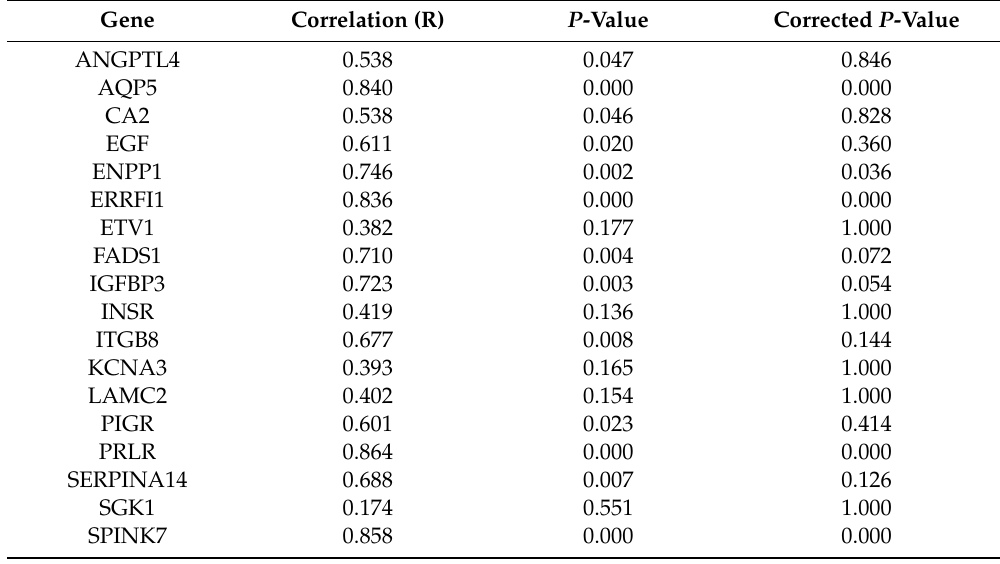
Table 2. Pearson’s correlation of RNA sequencing (Fragments Per Kilobase of transcript per Million mapped reads) and quantitative real-time PCR ( − ∆ CT) to confirm RNA sequencing